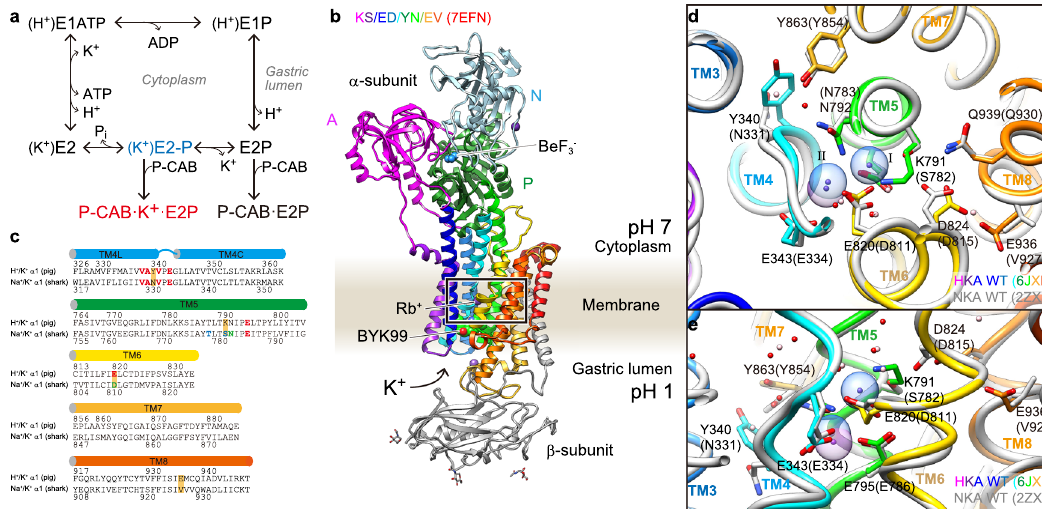
Fig. 1 Comparison of the primary and tertiary structures of HKA and NKA. a The reaction cycle of HKA. P-CAB (K + -competitive acid blockers) preferentially bind to the luminal-open E2P state from the luminal side of the membrane, and inhibit the enzyme (P-CAB·E2P). E2P is labile in the presence of luminal K + , and proceeds to dephosphorylation. Transition state analog AlF traps the enzyme in the K + -occluded (K + )E2-P transition state (blue). In the presence of K + , BeF, and P-CAB, the enzyme is trapped in the P-CAB·K + ·E2P state via the reverse reaction (red). b Overall structure of HKA Lys791Ser/ Glu820Asp/Tyr340Asn/Glu936Val quadruple mutant in BYK99 and Rb + -bound E2BeF state determined in this study, is shown in ribbon representations. For the α -subunit, the three cytoplasmic domains (A, P, and N) are shown in different colors. The color of the TM helices gradually changes from purple to red (TM1-TM10). The β -subunit with a single TM helix and six N -glycosylation sites (three shown in sticks) in the ecto-domain is shown in gray. Blue and purple spheres represent BeF and Rb + , respectively. c Sequence alignment of a part of TM helices of HKA (pig) and NKA (shark). Amino acids shown in blue are involved in the K + coordination at site I, red for site II and green for both sites. Yellow boxes indicate amino acids evaluated in this study. d , e Close-up view (boxed region in b ) of the cation-binding sites of HKA (K + ) E2-MgF state (6JXH, color codes as in b ) with superimposed NKA (K + ) 2 E2-MgF state (2ZXE, gray) aligned, based on their TM7-TM10 structures, viewed from cytoplasmic side ( d ) and along the membrane plane ( e ). Rb + (purple dot with transparent sphere indicating its ionic radius) in HKA and two K + ions at sites I and II in NKA (blue dot and spheres) are shown. Only amino acid residues focused on in this study are shown for clarity. Amino acids in NKA are indicated in